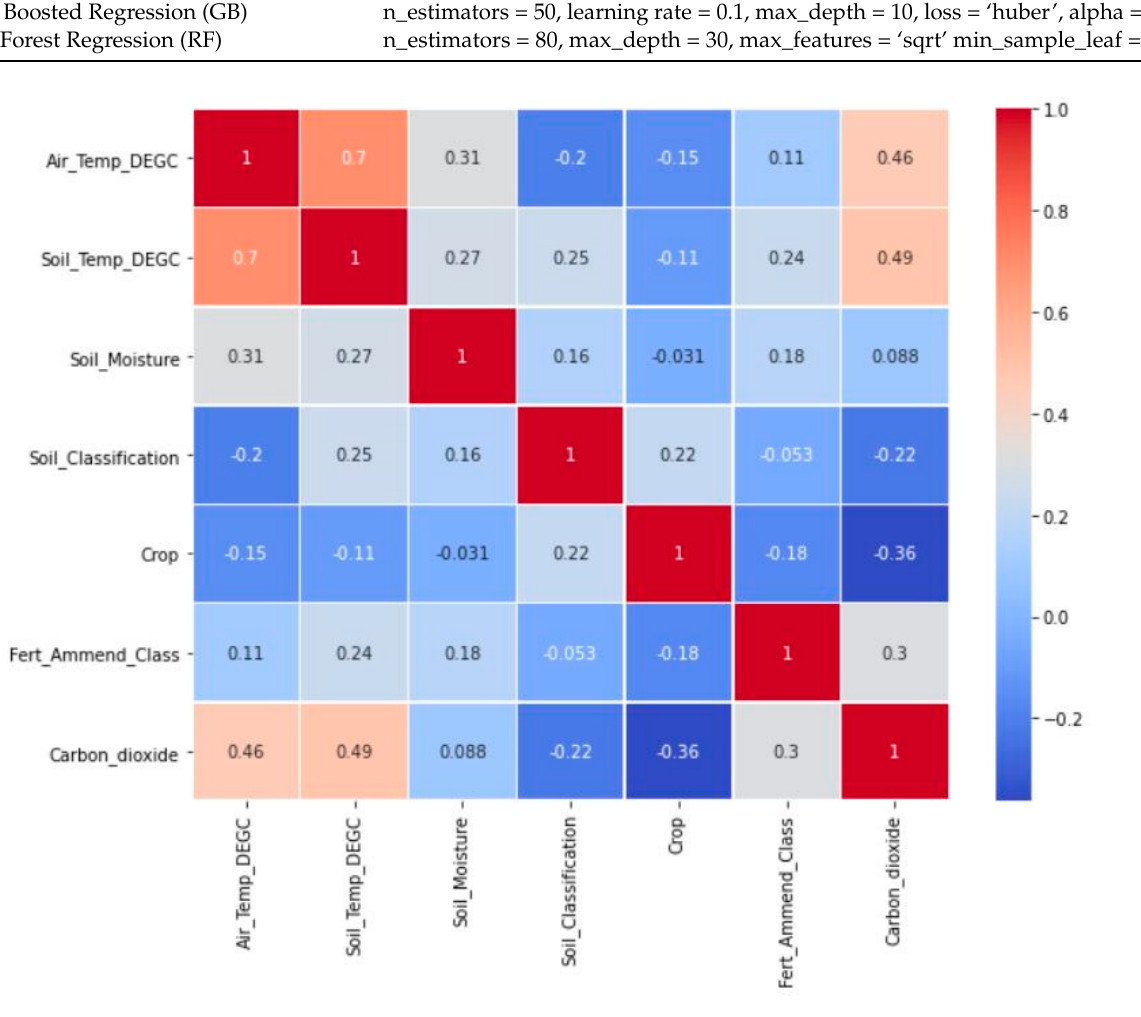
Figure 2. Pearson heat map showing a correlation matrix between the predictor variables and CO 2 flux.